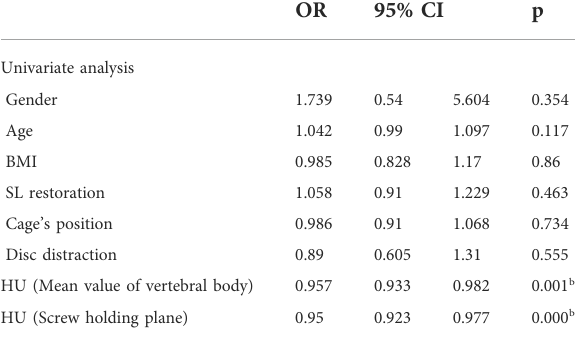
TABLE 5 Logistic regression analysis of the caudal screw loosening.